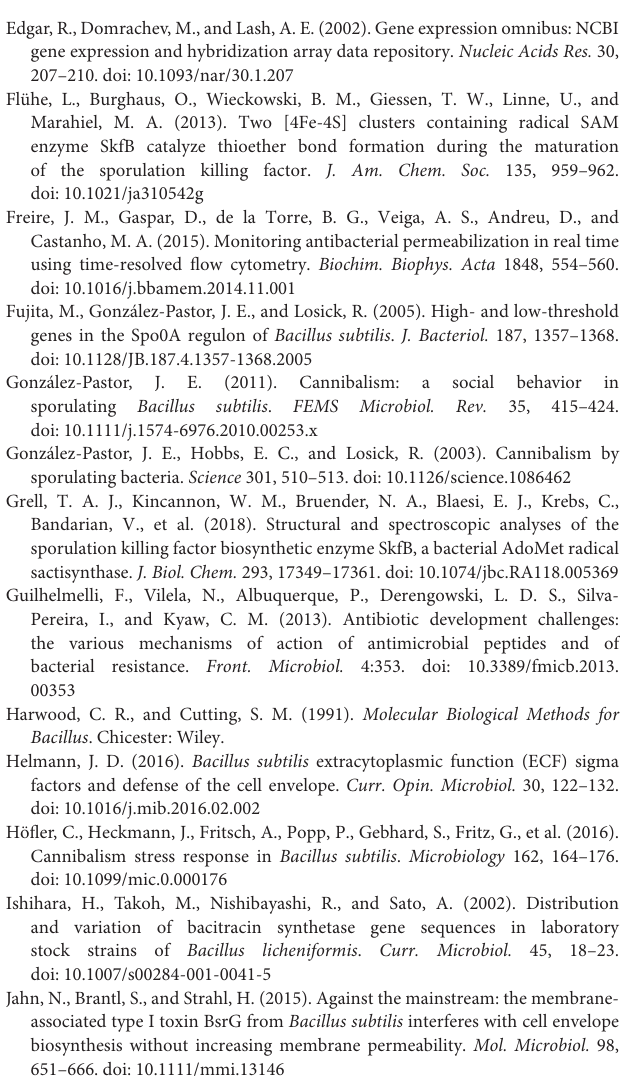
Figure S1 | Growth curves and luciferase activity of B. subtilis P liaI - lux strains in full medium. Upper panel depict growth curves, lower panel show luminescence